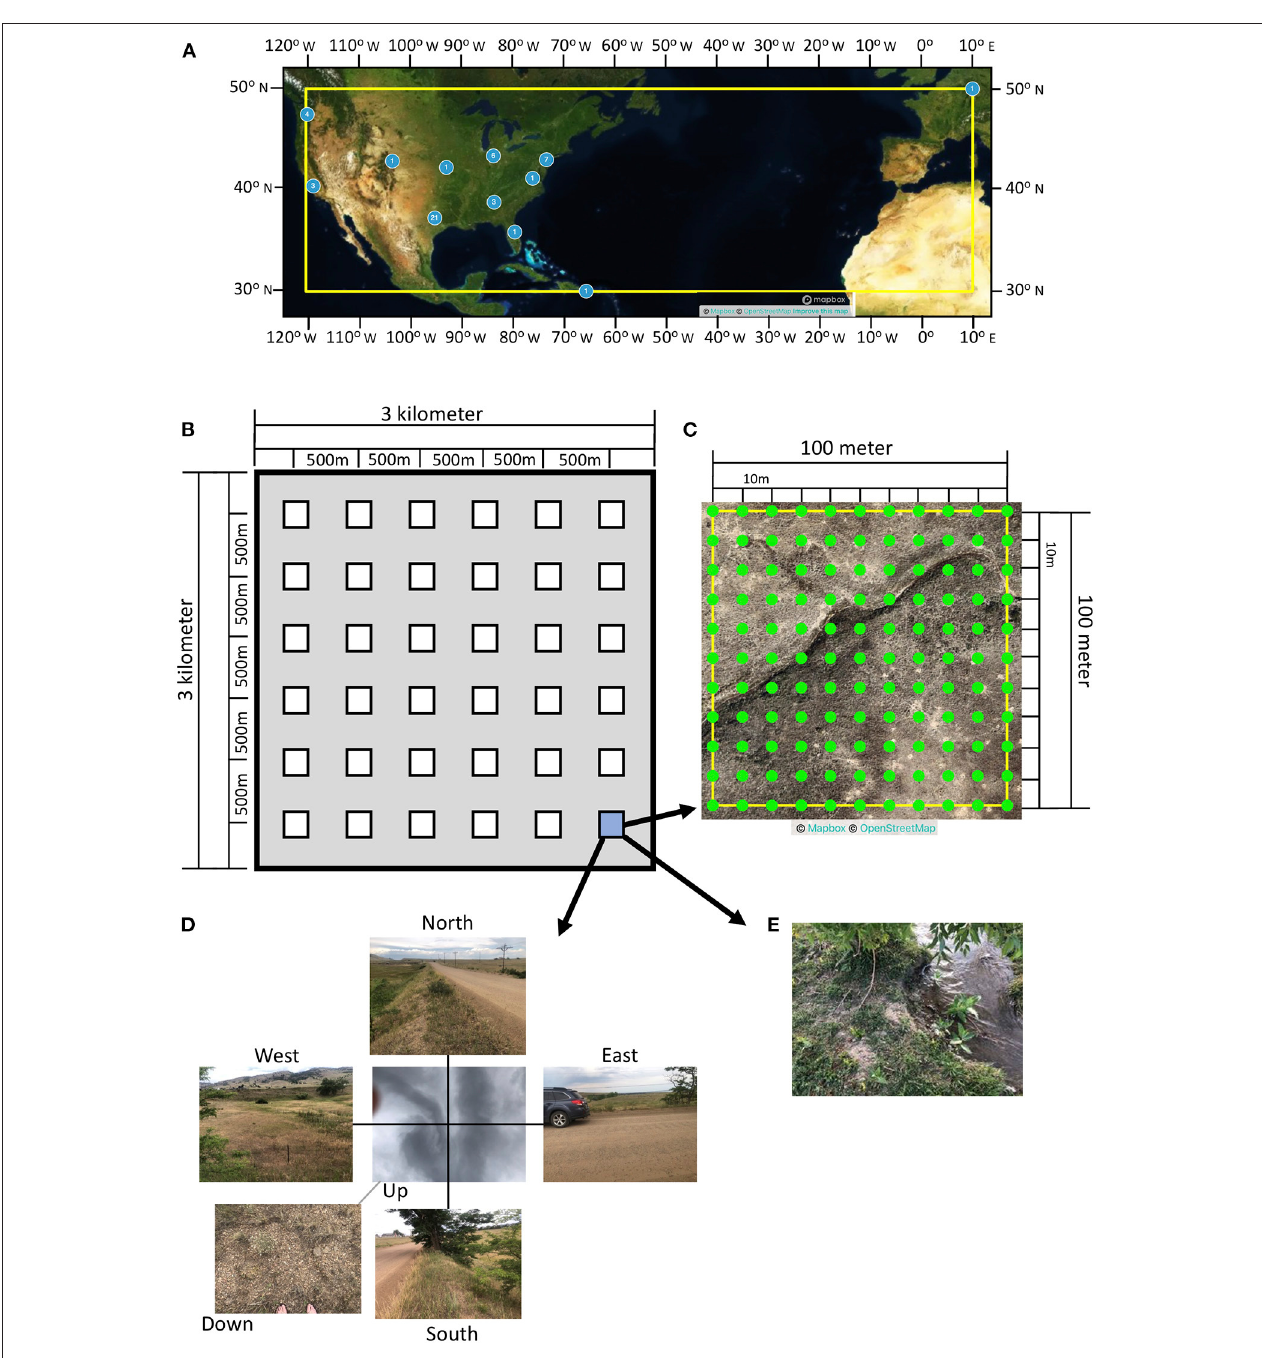
FIGURE 1 | The research design collected reference samples at multiple scales. (A) Geographic location of the 49 Areas of Interest. (B) Within each Areas of Interest, defined as a 3 × 3km area, there are 36 Primary Sample Units spaced on a systematic grid 500m apart. (C) Each Primary Sample Unit is a 100 × 100m area: very high resolution satellite imagery is characterized using a dot grid with equal spacing of 10m. This results in a total of 121 samples which allows calculation of fractional land cover estimates. (D) Ground reference images are collected within the Area of Interest using the GLOBE Observer Land Cover tool. (E) Mosquito habitat data is collected using GLOBE Observer Mosquito Habitat Mapper within each Area of Interest whenever